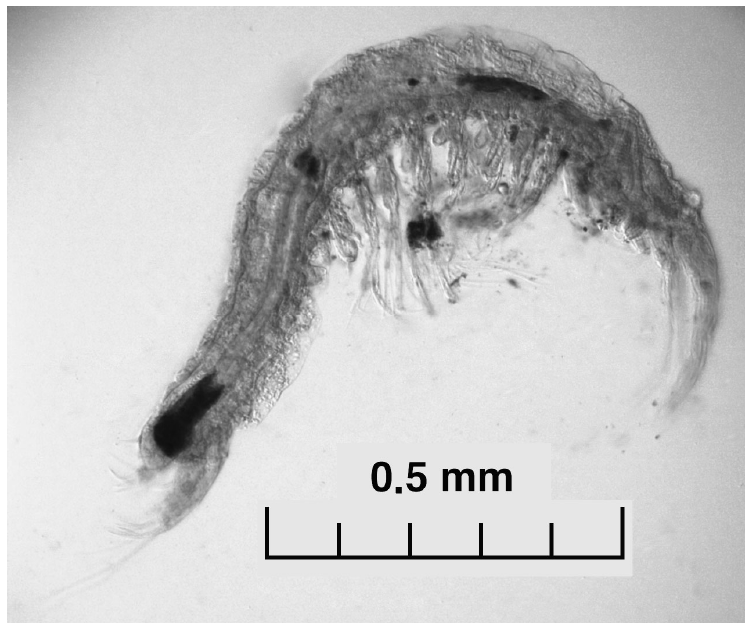
Figure 6. Habitus of Vejdovskybathynella edelweiss Camacho, 2007.